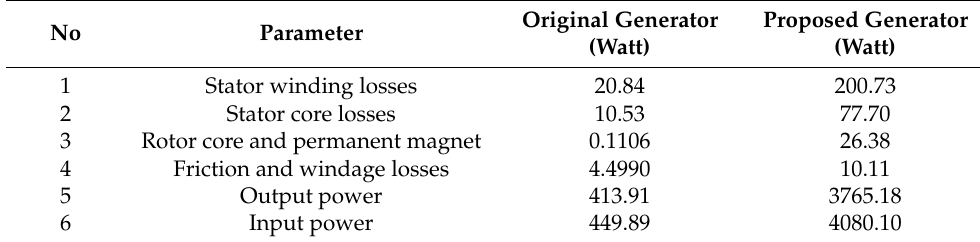
Table 7. Some losses produced by the original and proposed generators.